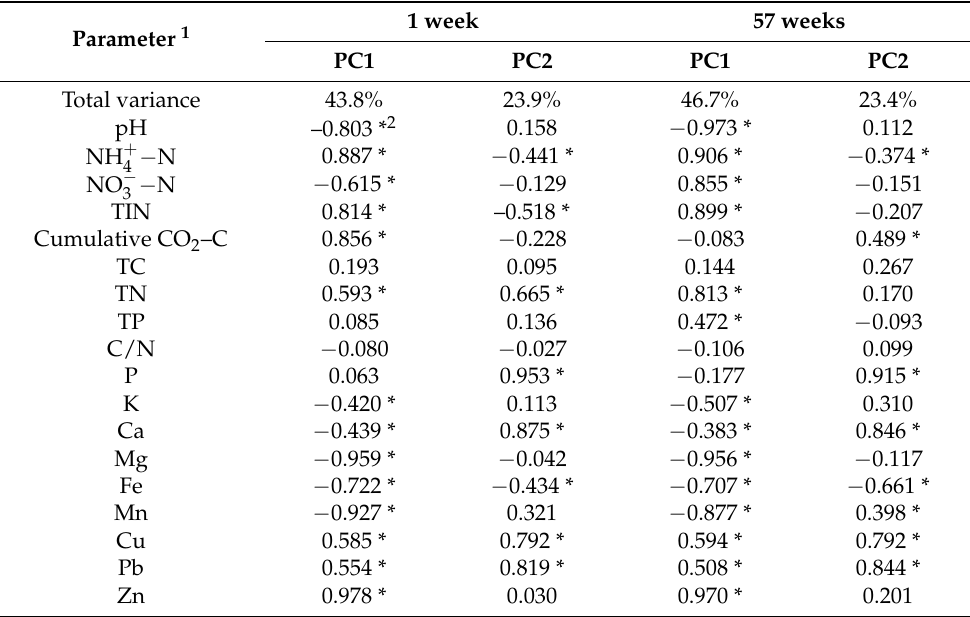
Table 5. Pearson correlation coefficients between measured parameters and principal components (PCs) (PC1 and PC2) at the 1st and 57th